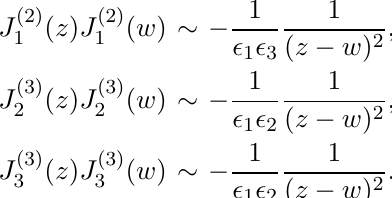
Figure 14. The web diagram associated to the b gl (2) Kac-Moody